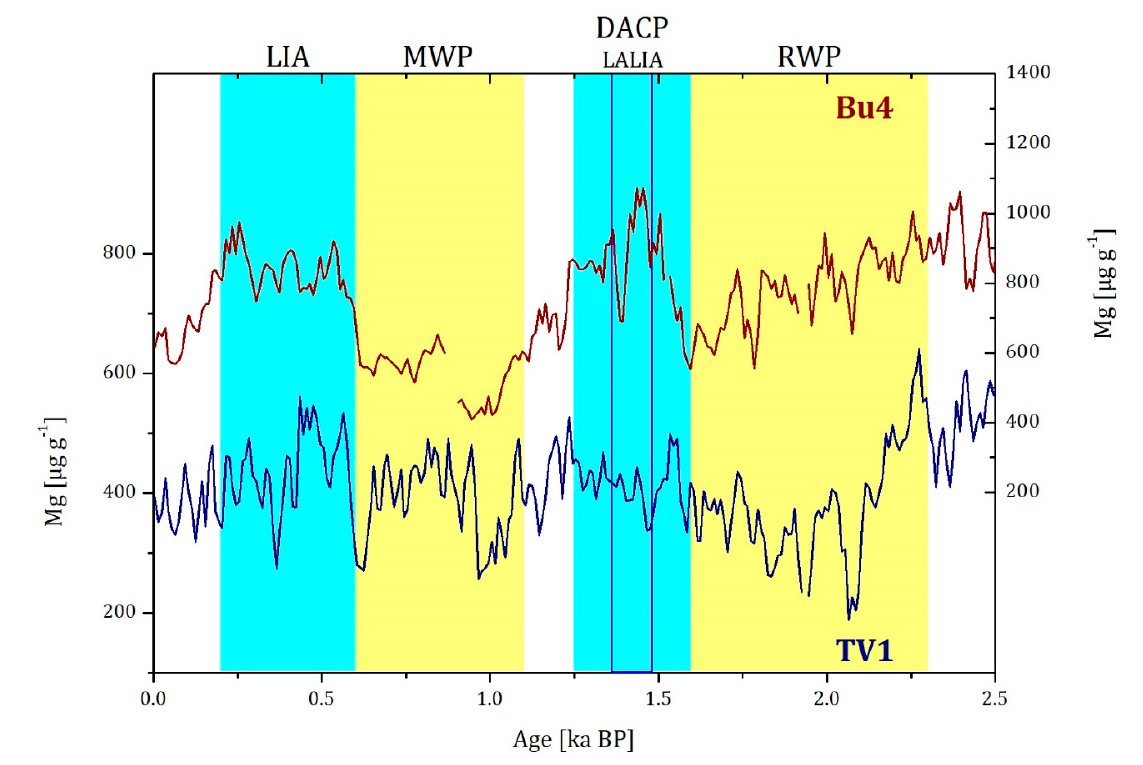
Figure 10. Mg records of speleothems Bu4 and TV1 with a temporal resolution of 10 years. Yellow bars indicate the MWP and the RWP as periods with warm and humid climate and blue bars indicate the LIA, the DACP and the LALIA as periods with cold and dry climate. Timing and duration of these cold and warm phases are shown as described in the literature [2,6,8,12,61] .